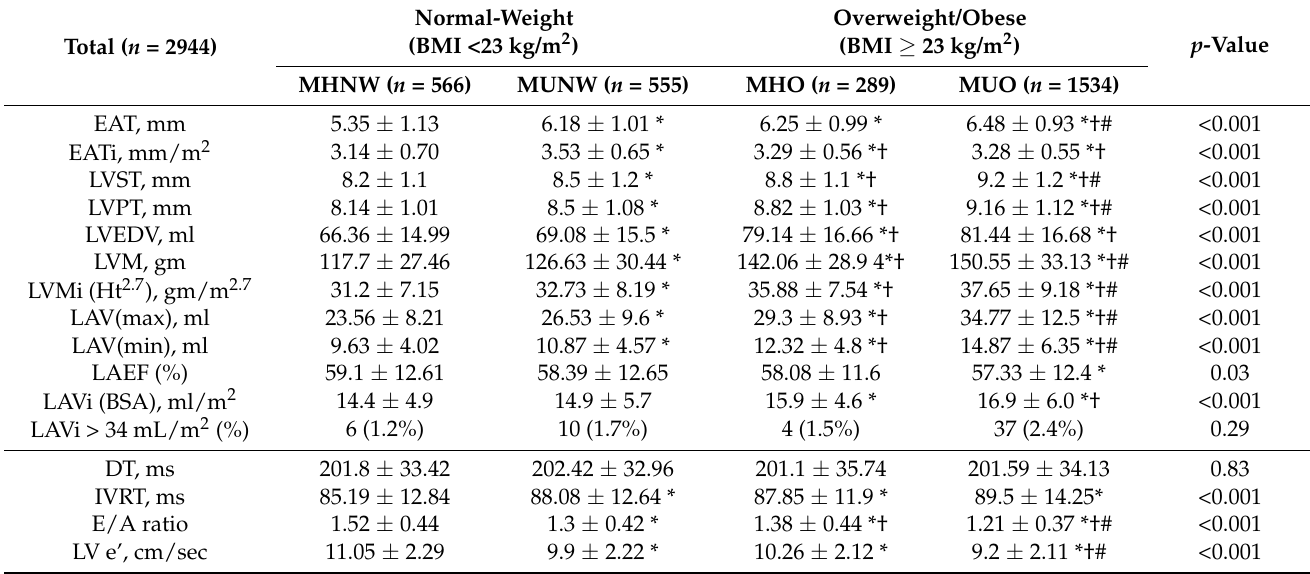
Table 2. Echocardiographic parameters of cardiac structure and mechanics according to obesity